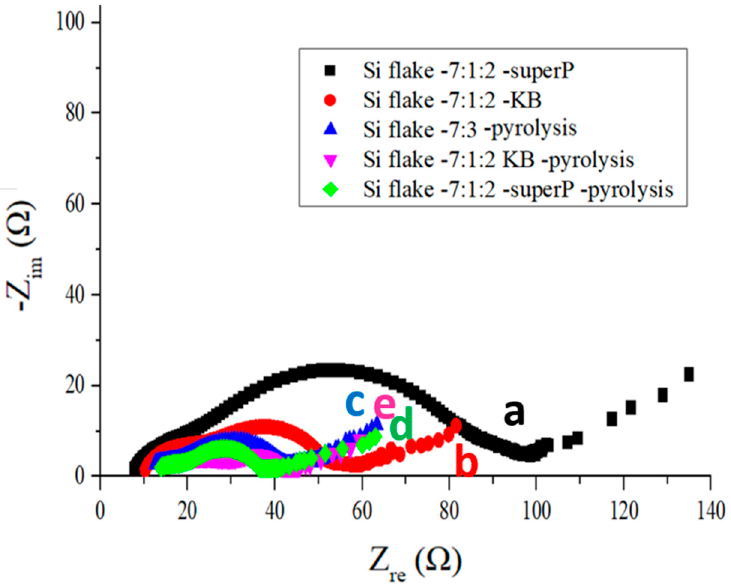
Figure 6. Electrochemical impedance spectra measured from anodes after the 200th cycle of discharge–charge: ( a ) (black square) anode made of silicon flakes:Super P:CMC/SBR = 70%:10%:20% in weight, ( b ) (red dots) anode made of silicon flakes:KB:CMC/SBR = 70%:10%:20% in weight, ( c ) (blue triangle) anode made of silicon flakes:CMC/SBR = 70%:30% in weight without a conductivity enhancement additive, ( d ) (pink inverted triangle) pyrolytic anode made of silicon flakes:KB:CMC/SBR = 70%:10%:20% in weight, and ( e ) (green diamond) pyrolytic anode made of silicon flakes:Super P:CMC/SBR = 70%:10%:20% in weight.